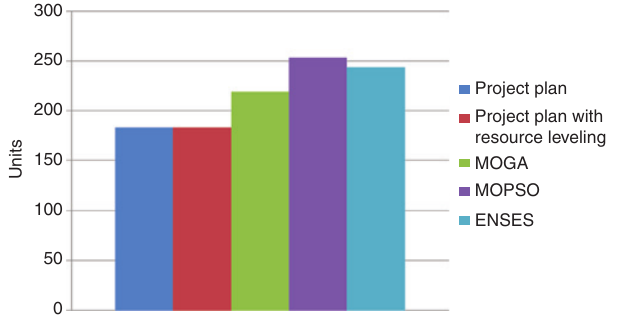
Figure 6: Resource Utilization of All Techniques.